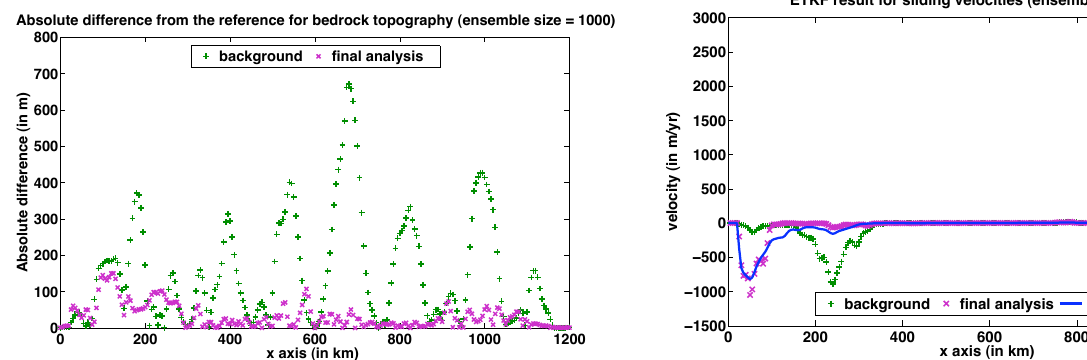
Fig. 11. Sliding component U slid of the surface velocity after 20 years of the 1000-member ETKF. The analysis mean (purple x) is compared to the background (green crosses) and the reference (blue).